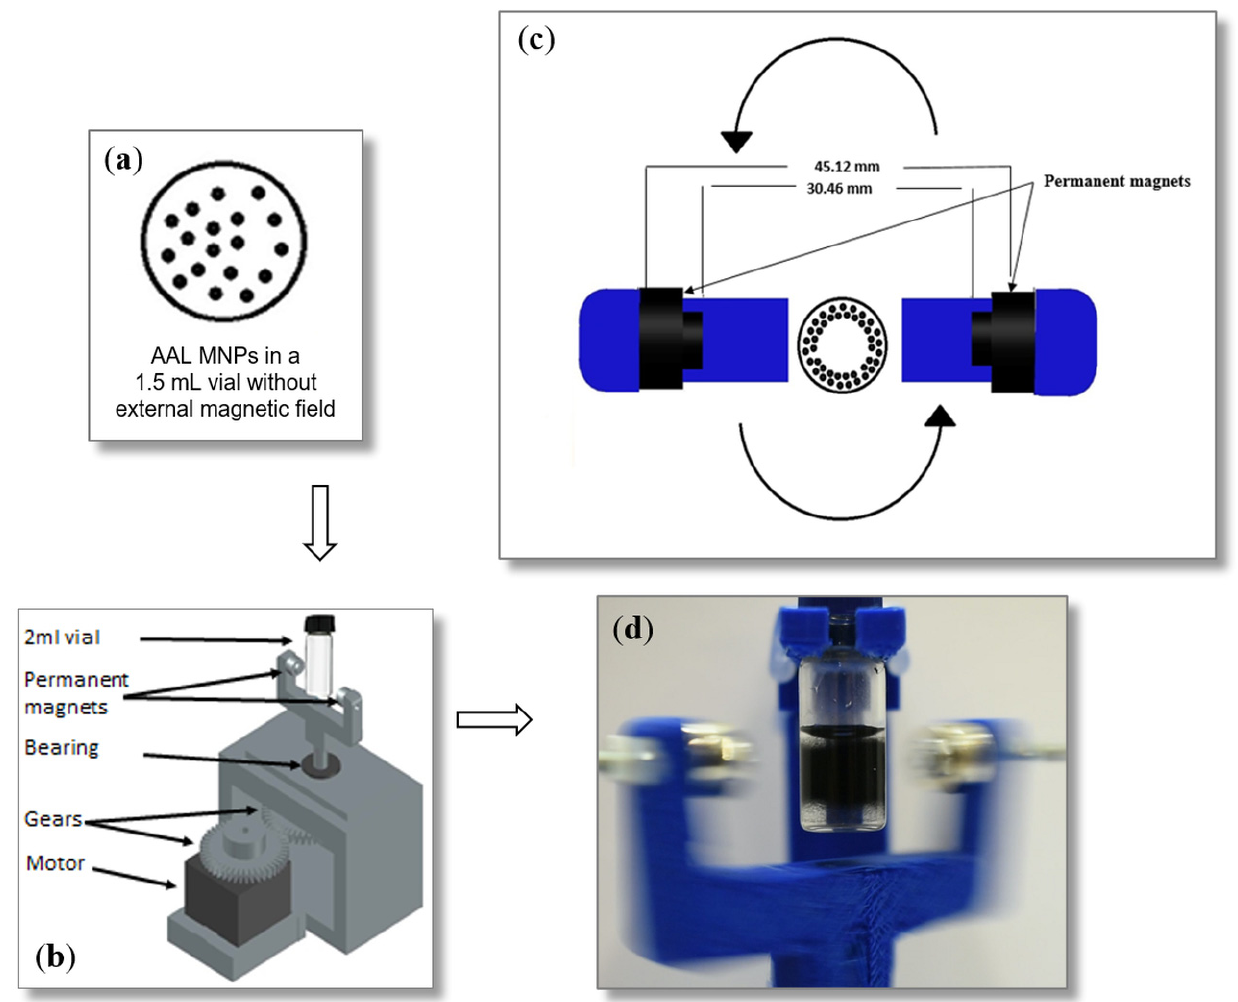
Figure 5. A device for rotating magnetic agitation of aspartate ammonia-lyase immobilized on magnetic nanoparticles (AAL-MNPs). The vial containing AAL-MNPs ( a ) was placed in a device ( b ) capable of rotating two permanent magnets in fixed distances around the y -axis of the centrally positioned AAL-MNP-containing vial ( c , d ). The external magnetic field generated by the two rotating permanent magnets in attraction configuration (RM att ) resulted in a ring-shaped MNP cloud ( c , d ). The movement frequency is characterized by the rpm (rotation per minute) value.